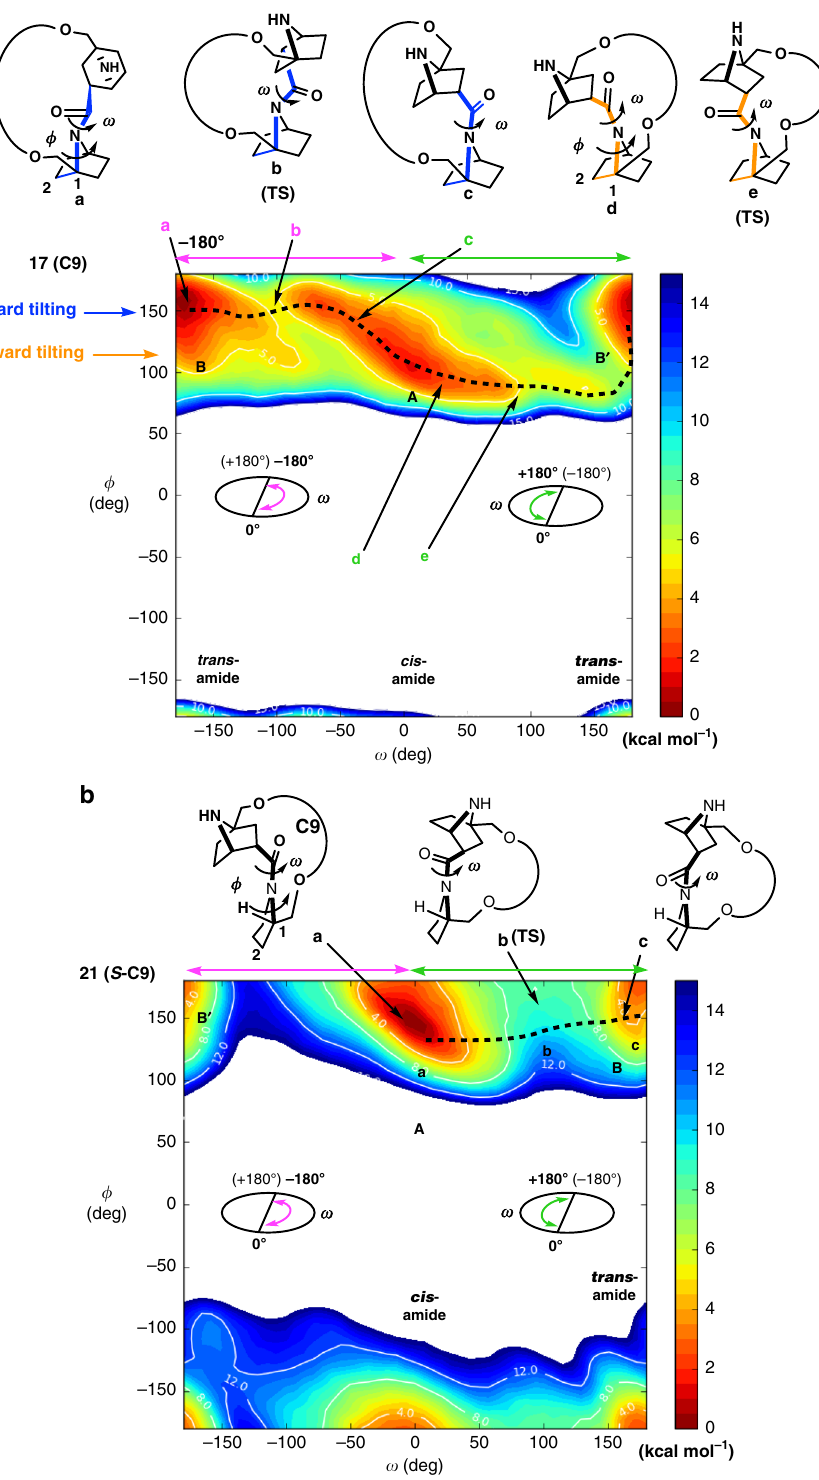
Fig. 6 The landscape of lactam amide rotation. a Metadymamic simulations of bicycle lactam 17(C9) in chloroform at 300 K. Dashed lines indicate the rotational pathways. The tilting direction of the pyramidal nitrogen atom of the bicyclic systems is synchronized with the direction of the semicircle- rotation of the amide. b Metadymamic simulations of monocycle lactam 21( S -C9) in chloroform at 300 K. Dashed lines indicate the rotational pathways. Rotation of the lactam amide bond is restricted to a south semicircle-rotation angle (e.g., 0° to +